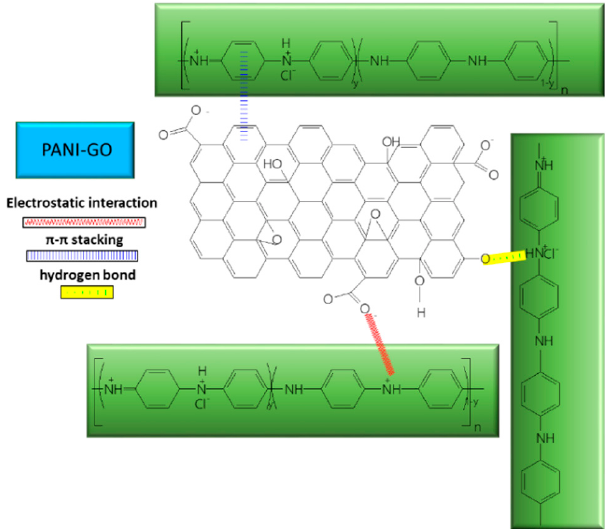
Figure 7. Interaction between GO and PANI in the composite used for UA detection.